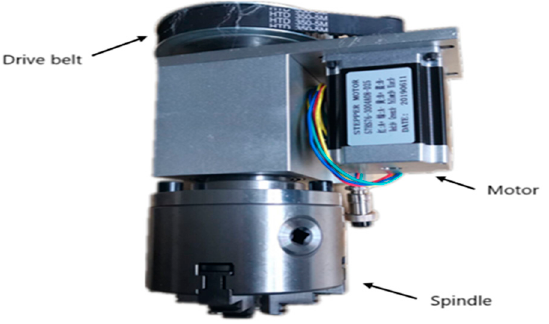
Figure 1. Rotary spindle unit of a CNC milling machine. (Source: https://www.dec-motor.com/, accessed date: 4 December 2021).